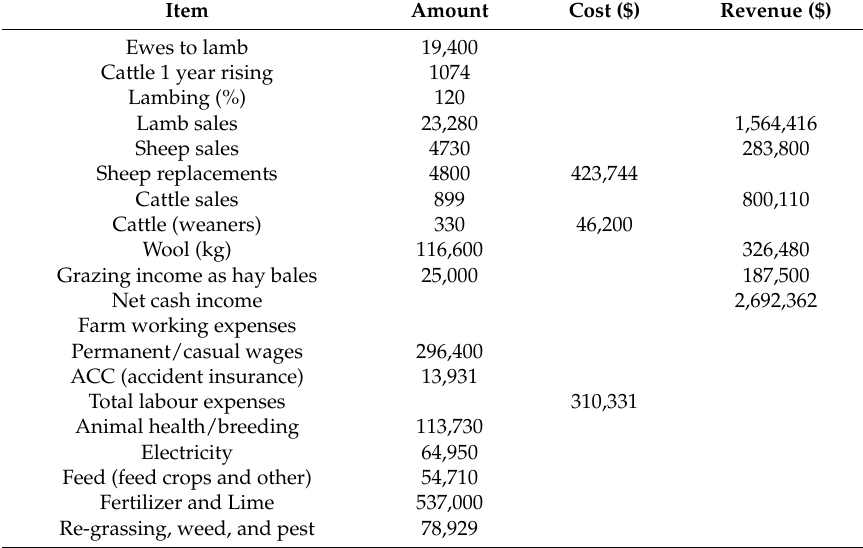
Table 3. The base set of accounts used for the sheep and beef Monte Carlo